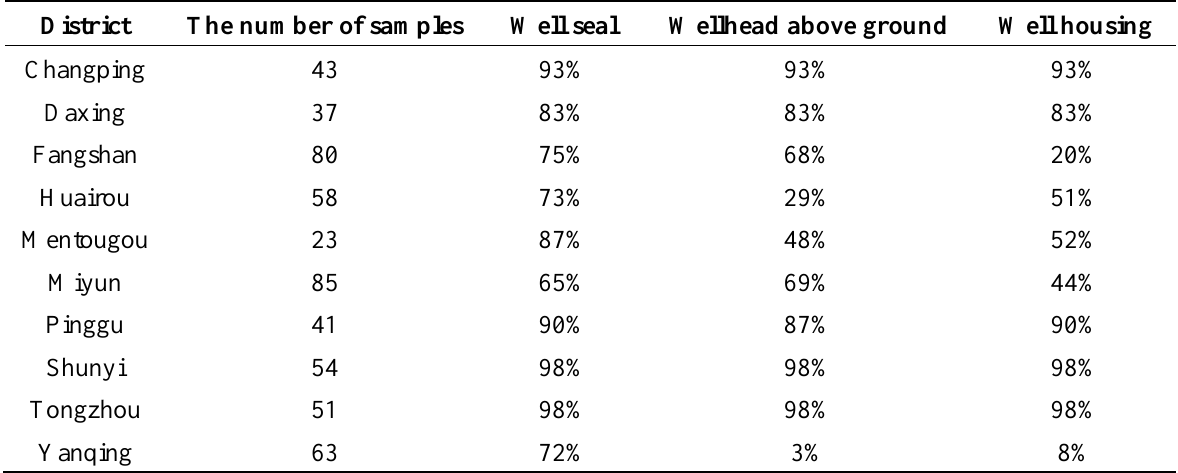
Table 3. Wellhead protections account for the proportion of the total number of survey. District